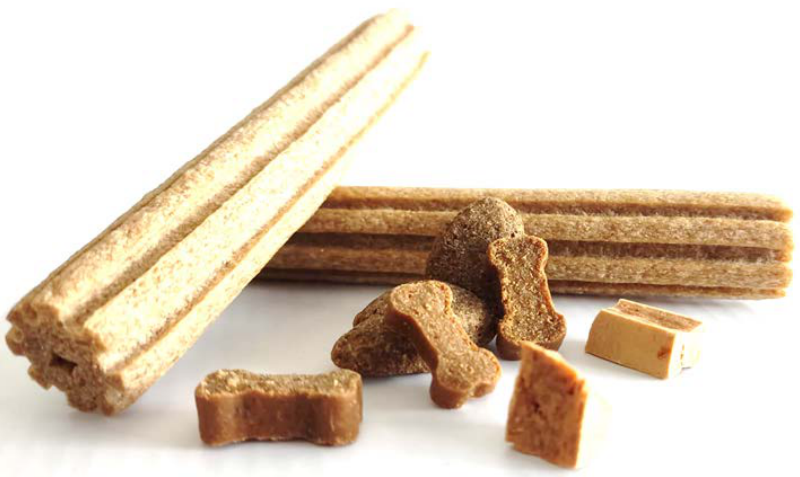
Figure 4. Dental treats and biscuits for dogs.